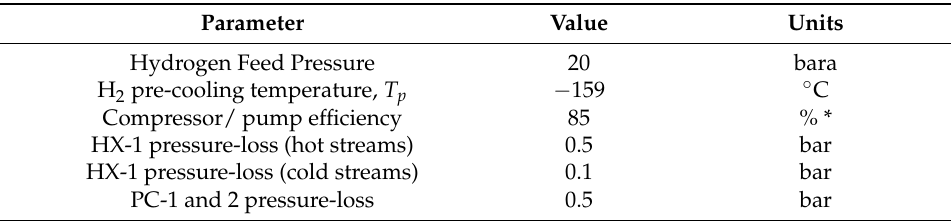
Table 1. Summary of MR process fixed modelling parameters.